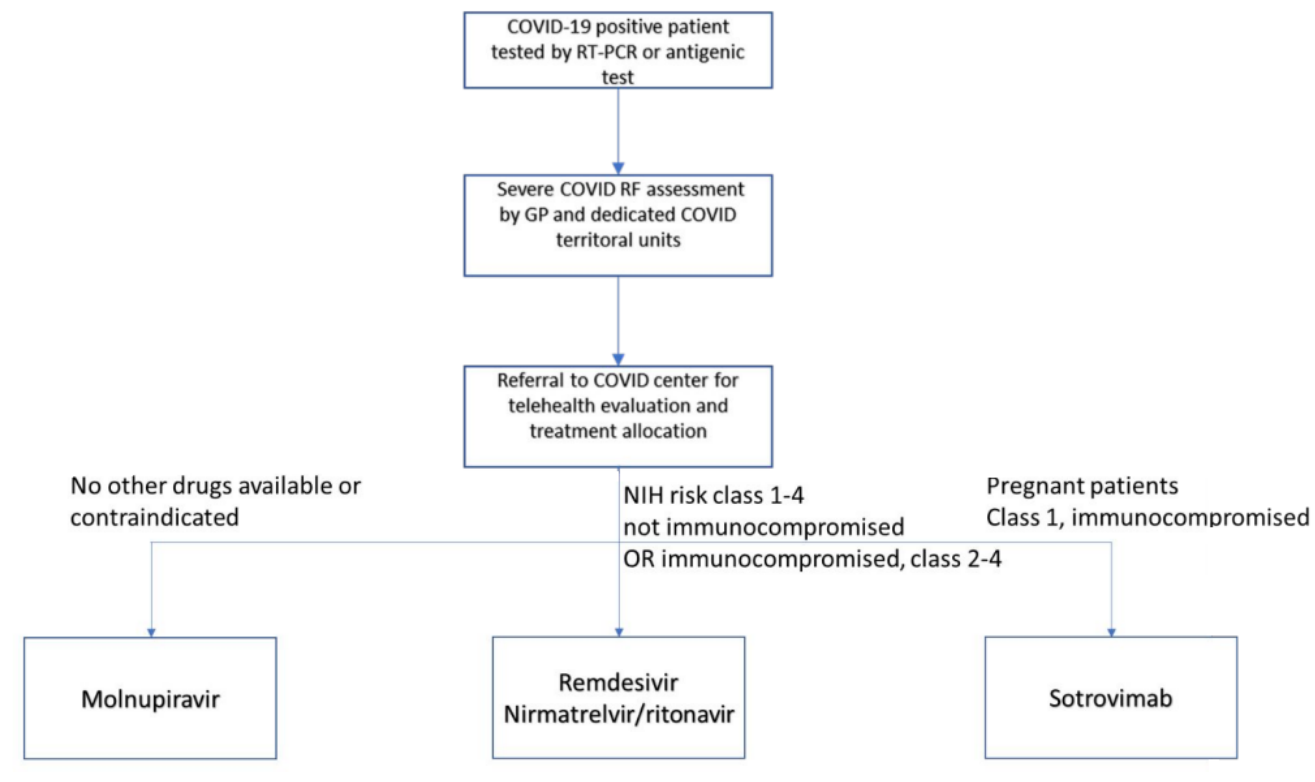
Figure 1. Flowchart for treatment allocation at our COVID-19 outpatient service. Risk classes were established according to the National Institutes of Health (NIH) statement on treatment allocations